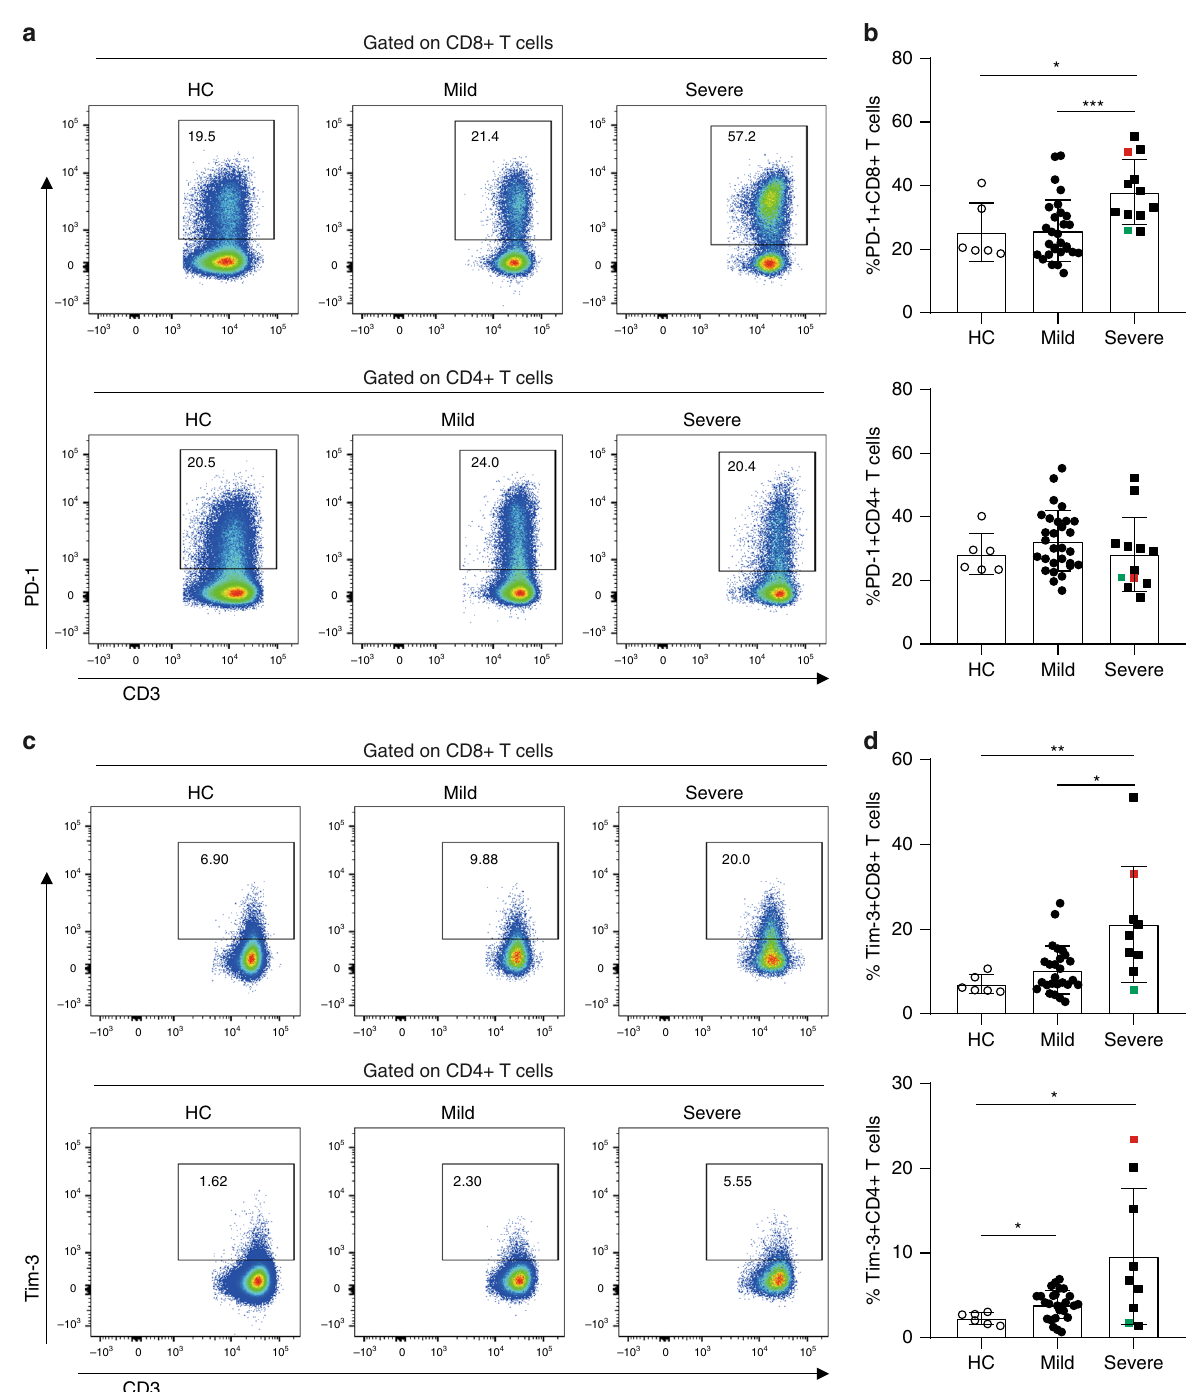
Fig. 3 Exhaustion of T cells in SARS-COV-2 infected patients. a , b PD-1 expression on CD8 + T and CD4 + T cells in HC ( n = 6), mild ( n = 29), and severe ( n = 12) patients of SARS-COV-2 infection. c , d TIM-3 expression on CD8 + T and CD4 + T cells in HC ( n = 6), mild ( n = 29), and severe ( n = 12) patients of SARS-COV-2 infection. Colored symbols indicated deceased cases. Data are expressed as mean ± SD. * p < 0.05, ** p < 0.01, *** p < 0.001, by two-tailed Mann – Whitney U -test for b ( p = 0.032 and p = 0.0005) and d ( p = 0.0076 and p = 0.0105 for Tim-3 + CD8 + T cells, and p = 0.0185 and p = 0.0496 for Tim-3 + CD4 + T cells, respectively). Source data included as a Source Data